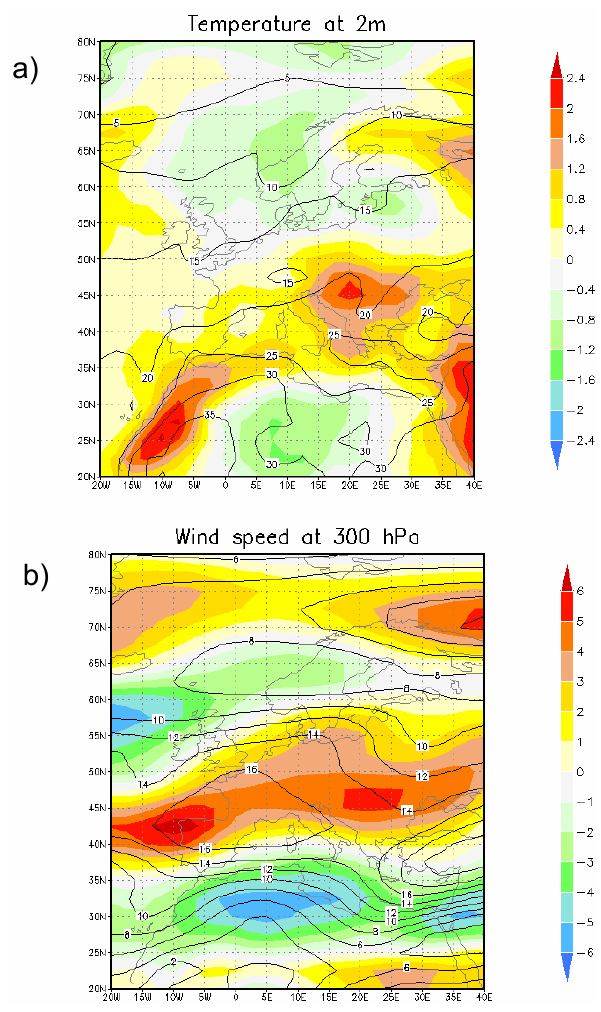
Figure 1. Anomalies of summer 2000 from the summer climatic mean over the period Fig. 1. Anomalies of summer 2000 from the summer climatic mean over the period 1961–1996 for (a) near surface air temperature and 1961-1996 for a) near surface air temperature and b) wind speed at 300 hPa. The contour (b) wind speed at 300hPa. The contour lines denote the mean val- lines denote the mean values of summer 2000. The source of the data is NCEP/NCAR ues of summer 2000. The source of the data is NCEP/NCAR Re- analysis 1 project (Kalnay et al., Reanalysis 1 project (Kalnay et al., 1996).